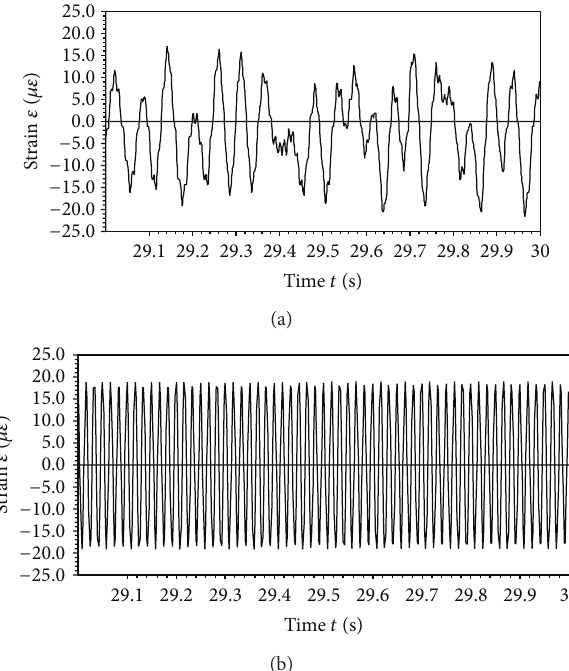
Figure 5: The time history of strain for the midpoint of the 5 # floor beam. (a) The time history of strain for the midpoint of the 5 # floor beamoftheprototype.(b)Thetimehistoryofstrainforthemidpoint of the 5 # floor beam of the scale